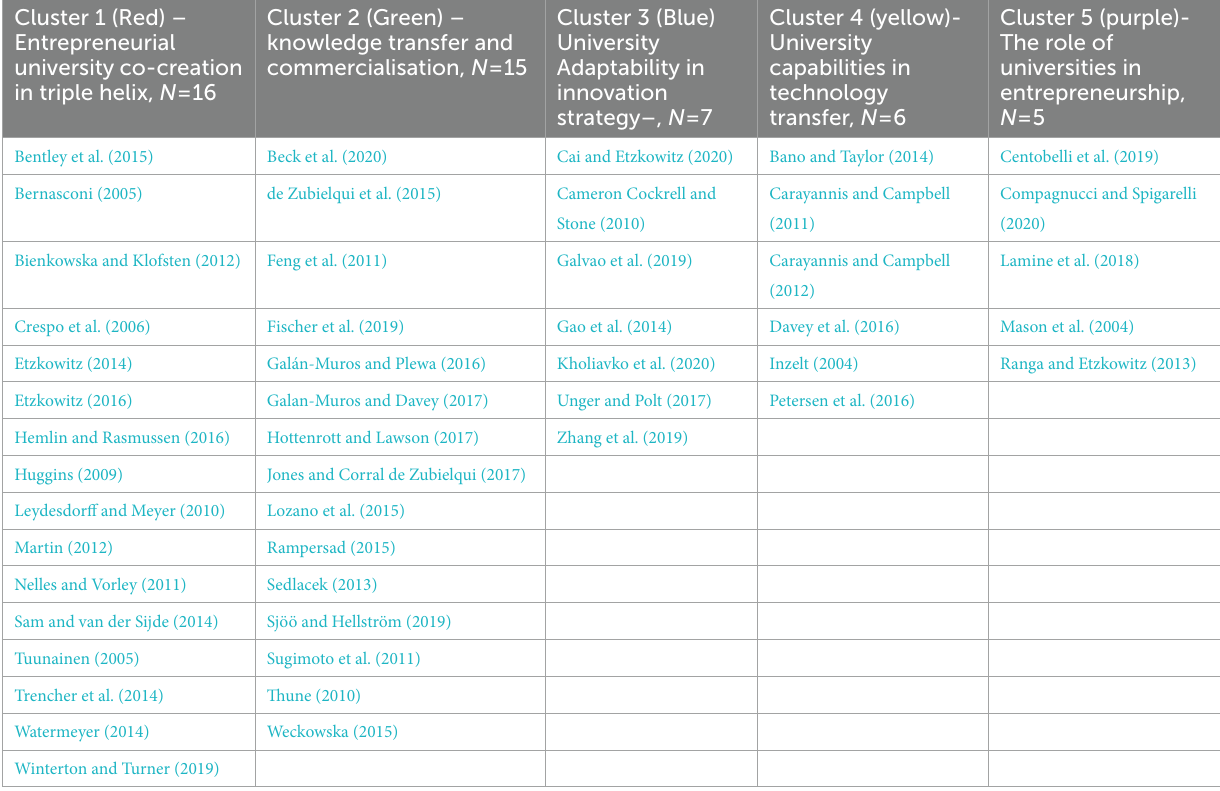
TABLE 5 Bibliographic coupling clusters on helix model and education. Cluster 1 (Red) –